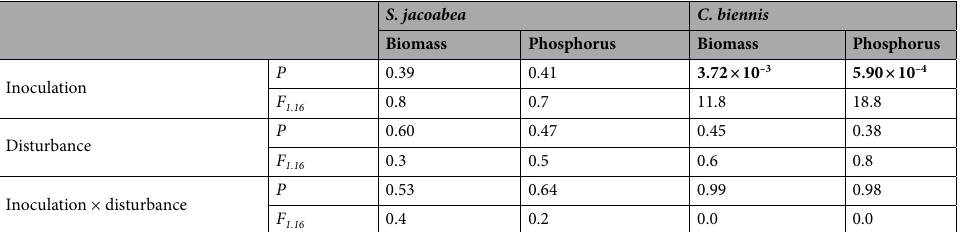
Table 1. Significance of effects of mycorrhizal inoculation and disturbance, and their interaction on perennial plants Senecio jacobaea and Crepis biennis contribution to total shoot dry biomass and total shoot phosphorus contents. F ‐ values (F) and levels of statistical significance ( p -value ranges, P ) as per two-way ANOVAs are shown (n = 5). Significant results are stated in